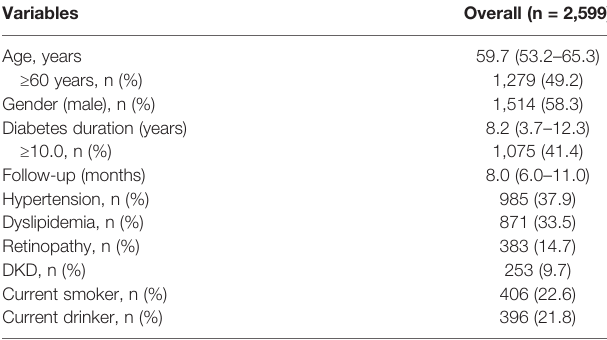
TABLE 1 | Demographic and clinical characteristics for the overall study population.